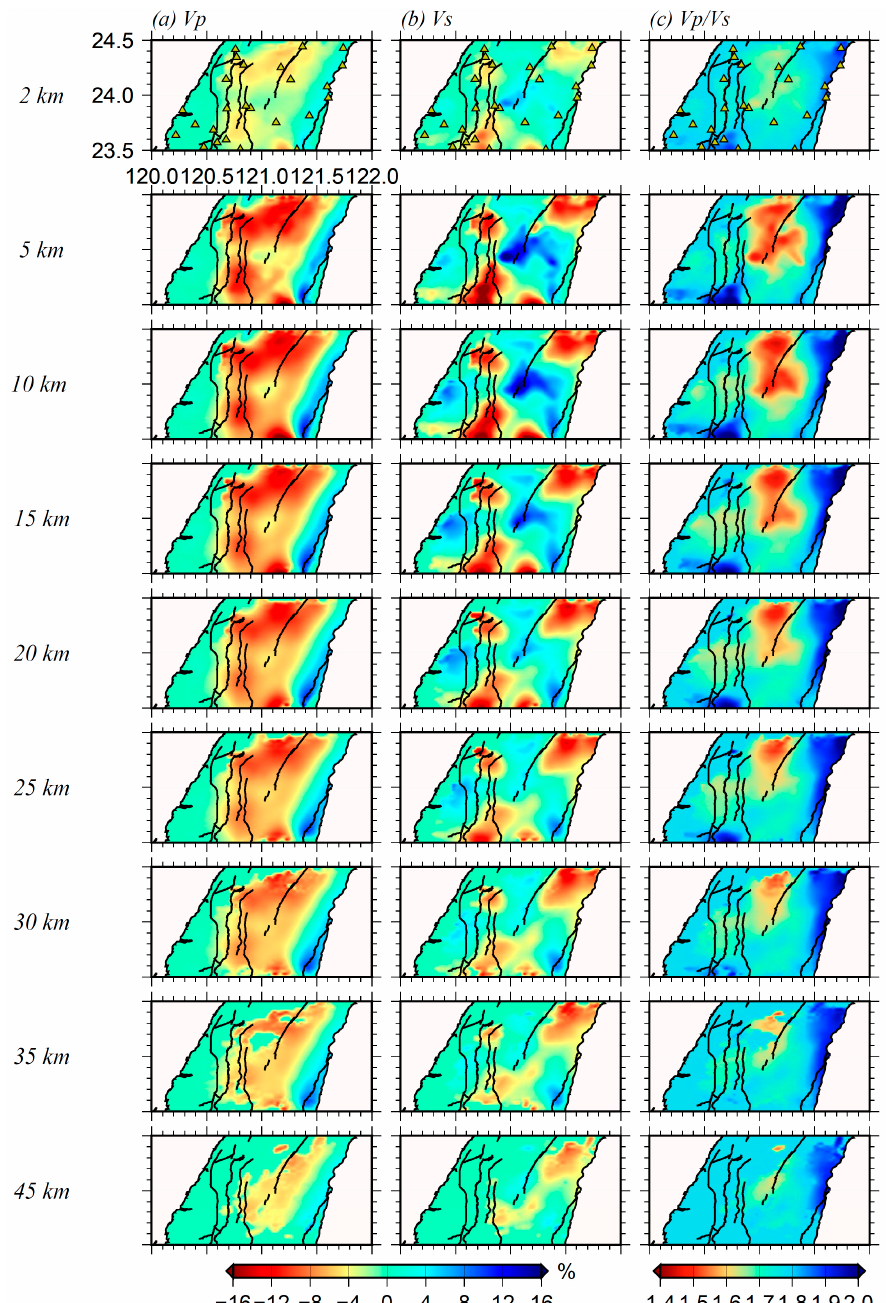
Figure A3. This study is divided into three periods to explore the Vp, Vs, and Vp/Vs in the study area. Yellow triangle represents the station. The results of Figure A3 represent the third period. ( a ) Vp at different depths. ( b ) Vs at different depths. ( c ) Vp/Vs at different depths.